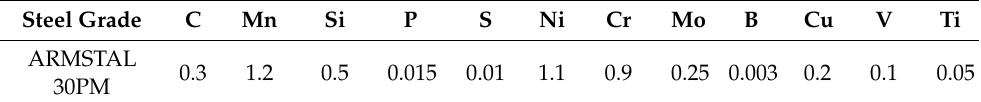
Table 1. Chemical composition (%) of the analyzed ARMSTAL 30PM steel [35].